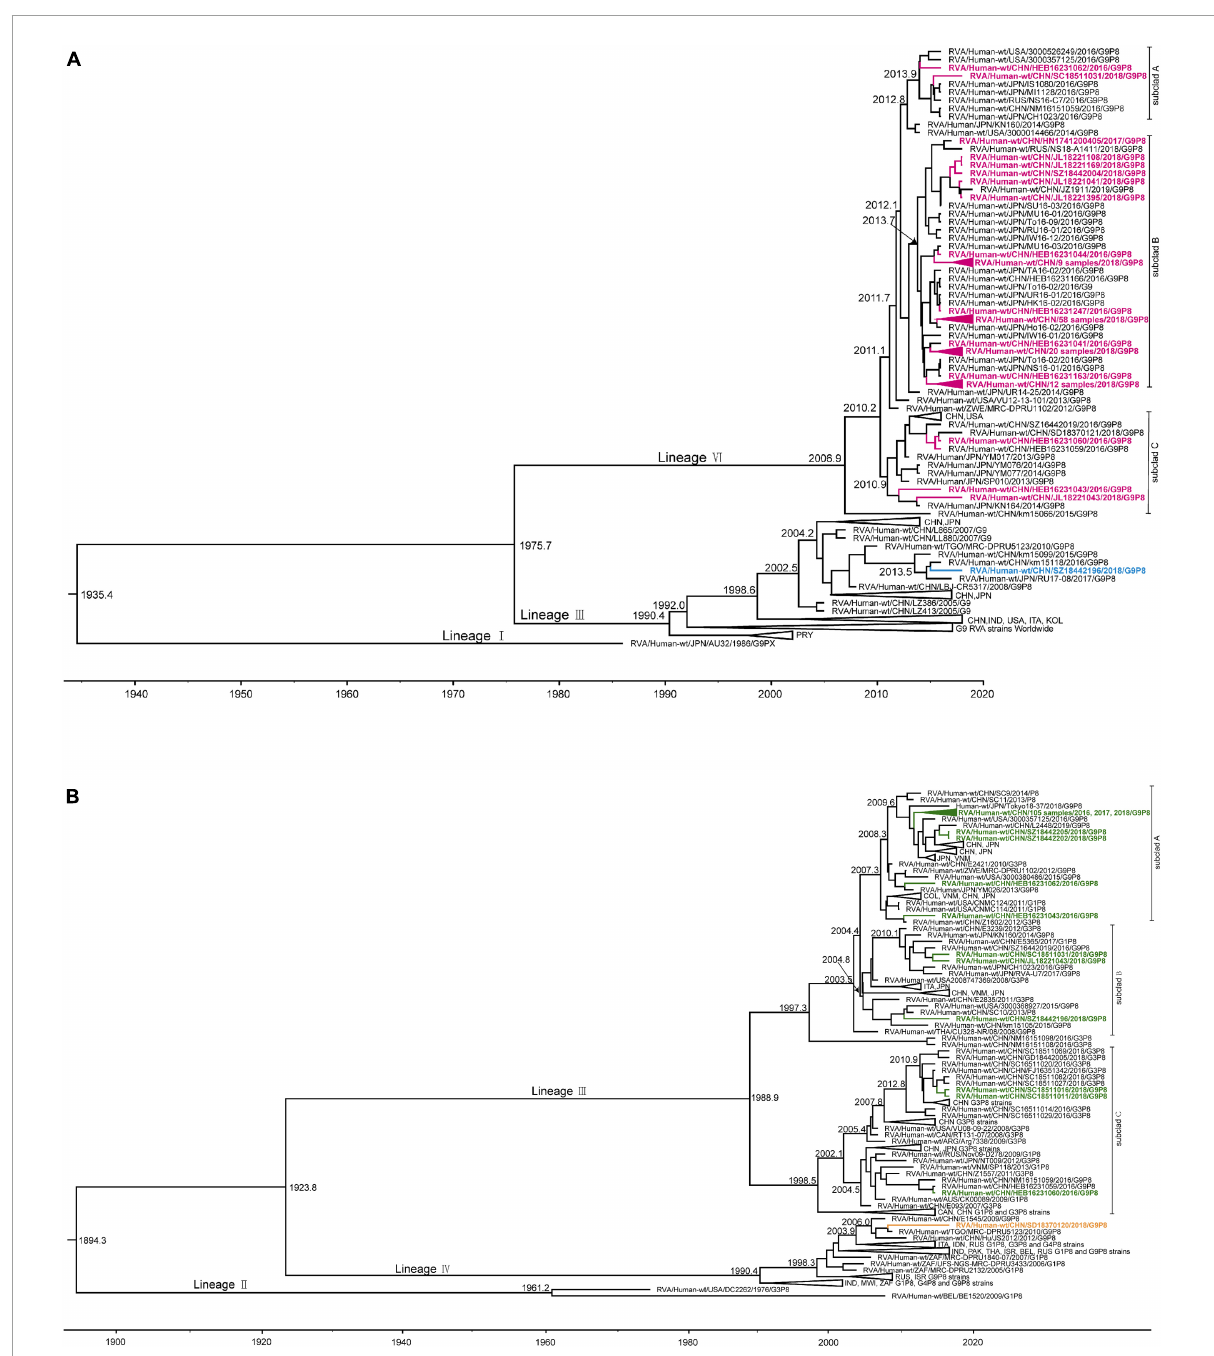
FIGURE3 Maximum clade credibility (MCC) tree of VP7 (A) and VP4 (B) for G9P[8] rotavirus with collapsed branches corresponding to the lineage subclades. The MCC tree was constructed by Bayesian Markov chain Monte Carlo analysis implemented in BEAST v. 1.8.4. Reference strain sequences were from GenBank (http://www.ncbi.nlm.nih.gov). The countries of isolation (ISO 3166-1-alpha-3 codes) and sampling times of the strains are indicated. In the VP7 MCC tree (A) , the tree branches for study strains of lineage VI are amaranth and those for lineage III are blue. In the VP4 MCC tree (B) , the tree branches for study strains of lineage III are green and those for lineage IV are orange.